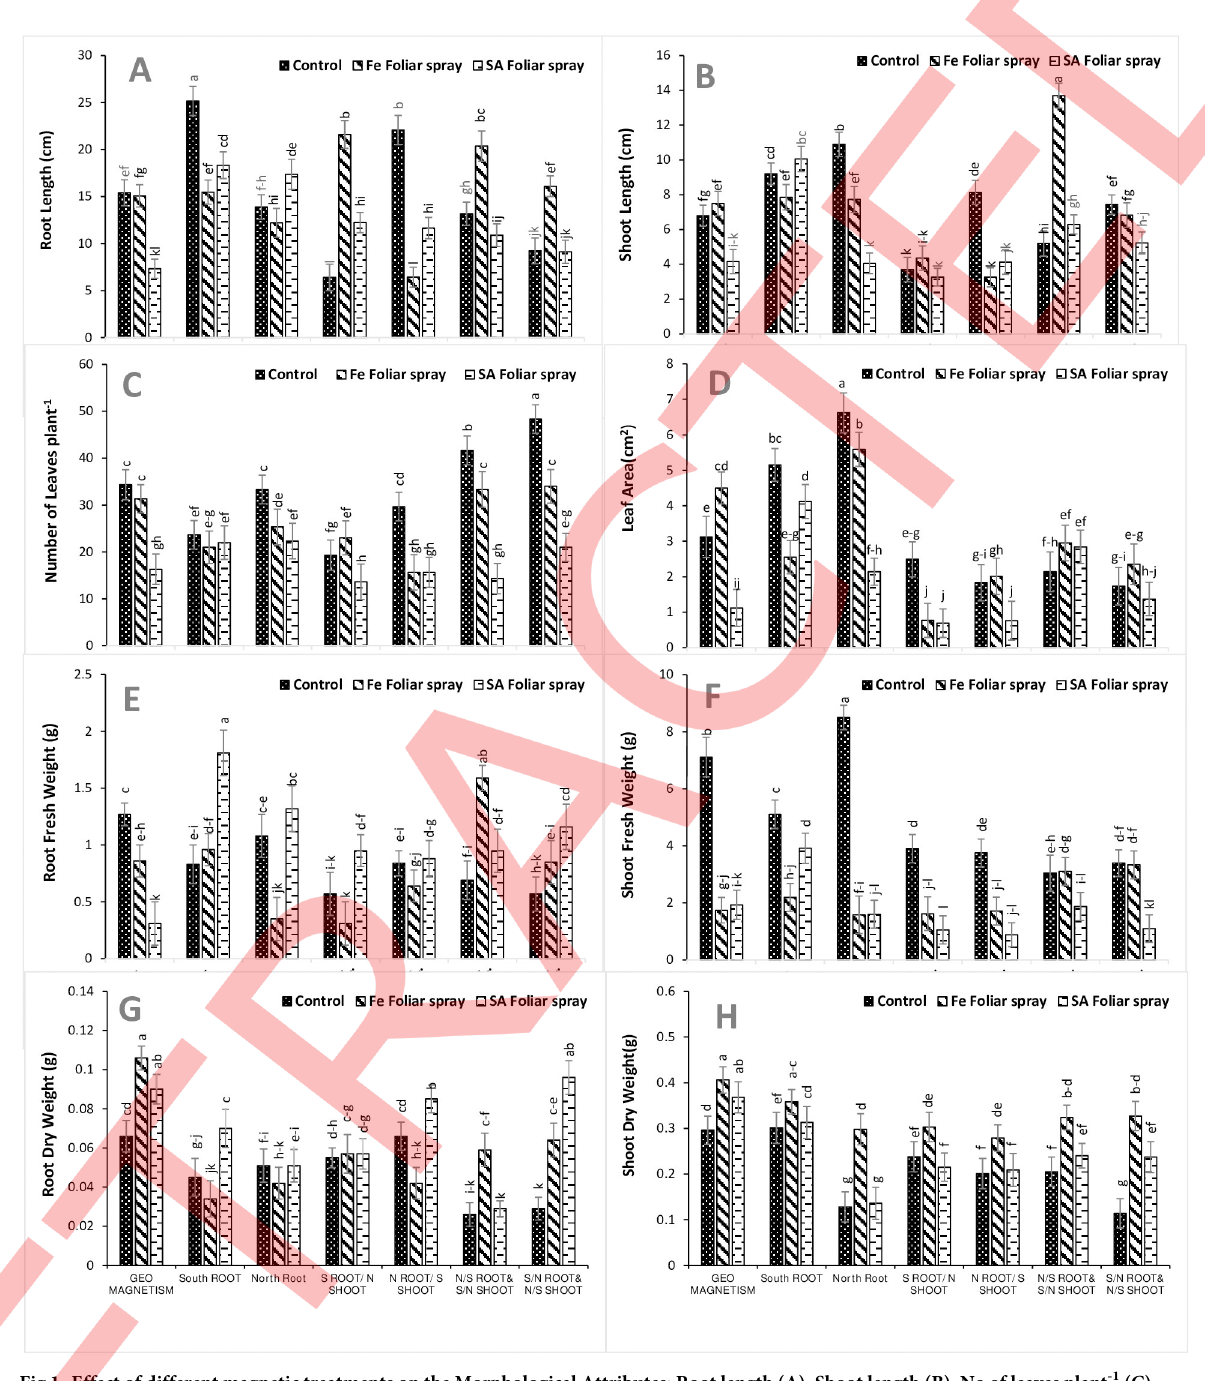
Fig 1. Effect of different magnetic treatments on the Morphological Attributes; Root length (A), Shoot length (B), No of leaves plant -1 (C), Leaf area (D) Root fresh weight (E), shoot fresh weight (F) Root dry weight (G), shoot dry weight (H) of Pisum sativum in response to Fe and SA Foliar Spray. The same letters on graphs represent statistically similar effect (P < 0.05).